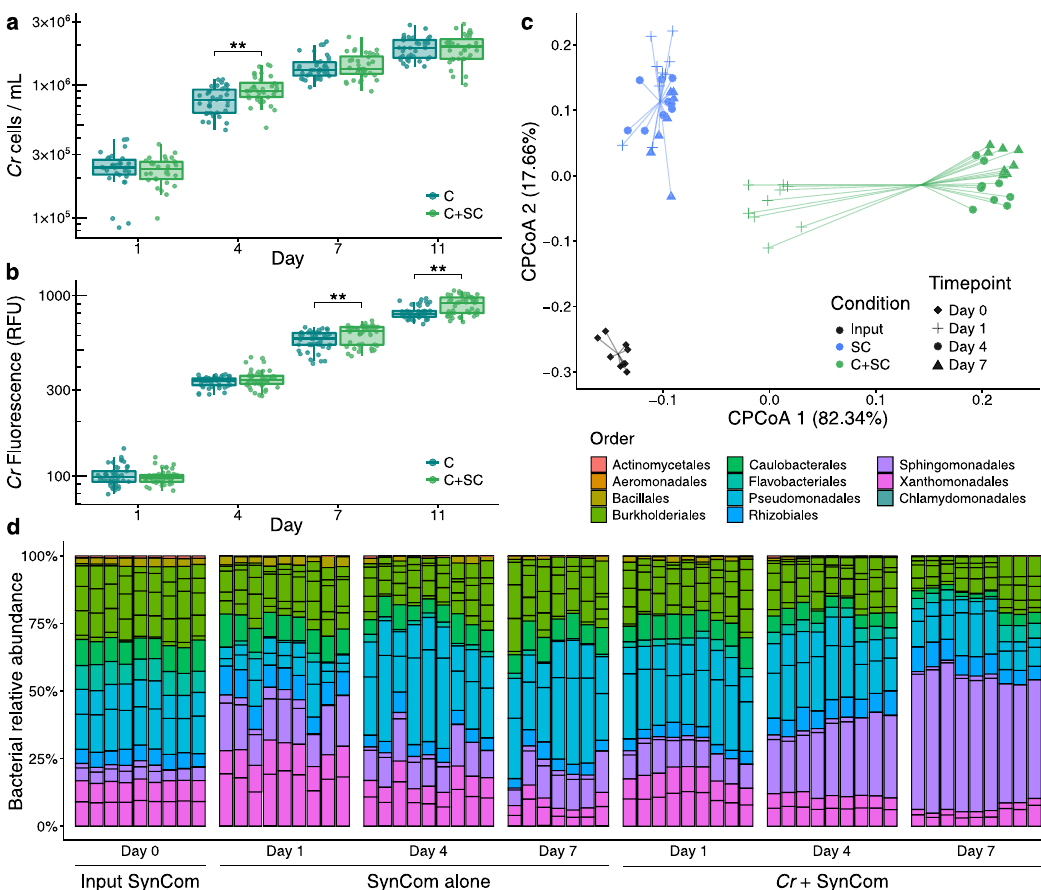
Fig. 4 Phycosphere reconstitution using bacterial SynComs derived from the Cr -SPHERE core culture collection. Cr growth in the gnotobiotic system axenically ( n = 36) or in co-inoculation with the bacterial SynCom ( n = 36), measured as algal cell densities ( a ), and chlorophyll fl uorescence ( b ). A Mann – Whitney test was used to assess signi fi cant differences among groups (FDR-corrected; P < 0.05). c Strain-level beta-diversity analysis (CPCoA of Bray – Curtis dissimilarities; 40.4% of the variance; P < 0.001) of bacterial communities from samples obtained from a liquid-based gnotobiotic system. Samples are color-coded based on the experimental condition: input SynCom samples (black; n = 9), synthetic phycospheres (light green; n = 27), and SynCom only controls (blue; n = 25). d Bar charts showing relative abundances of individual SynCom members across conditions and time points. Corresponds to experiment F (Supplementary Fig. 1f and Supplementary Table